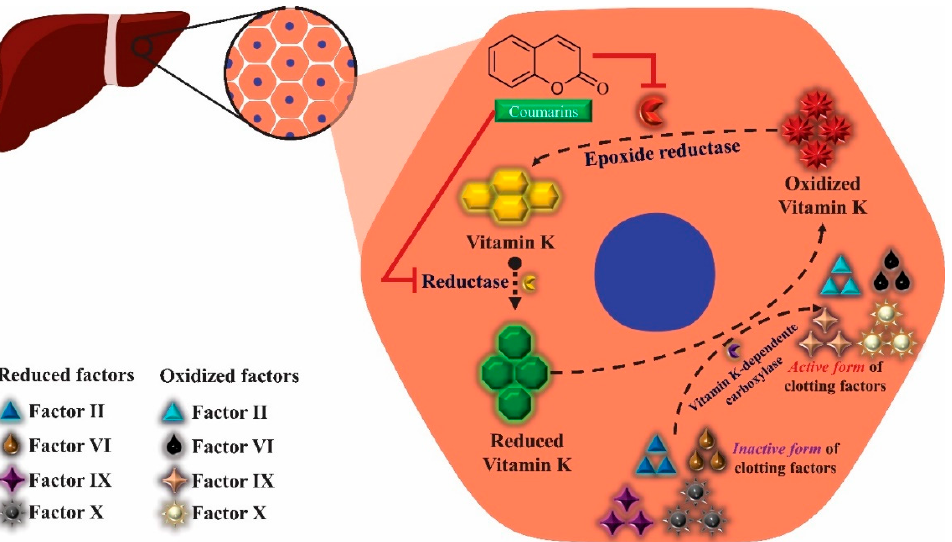
Figure 4. Proposed mechanism for inducing hemorrhage by coumarins: Coumarins act as competitive epoxide reductase inhibitors. This enzyme reduces oxidized vitamin K during its participation as co-factor in the synthesis of coagulation factors II, VII, IX, and X. With epoxide reductase inhibition, the reduction that occurs to regenerate vitamin K is blocked, depleting its levels and, consequently, inhibiting the synthesis of coagulation factors, causing hemorrhage.